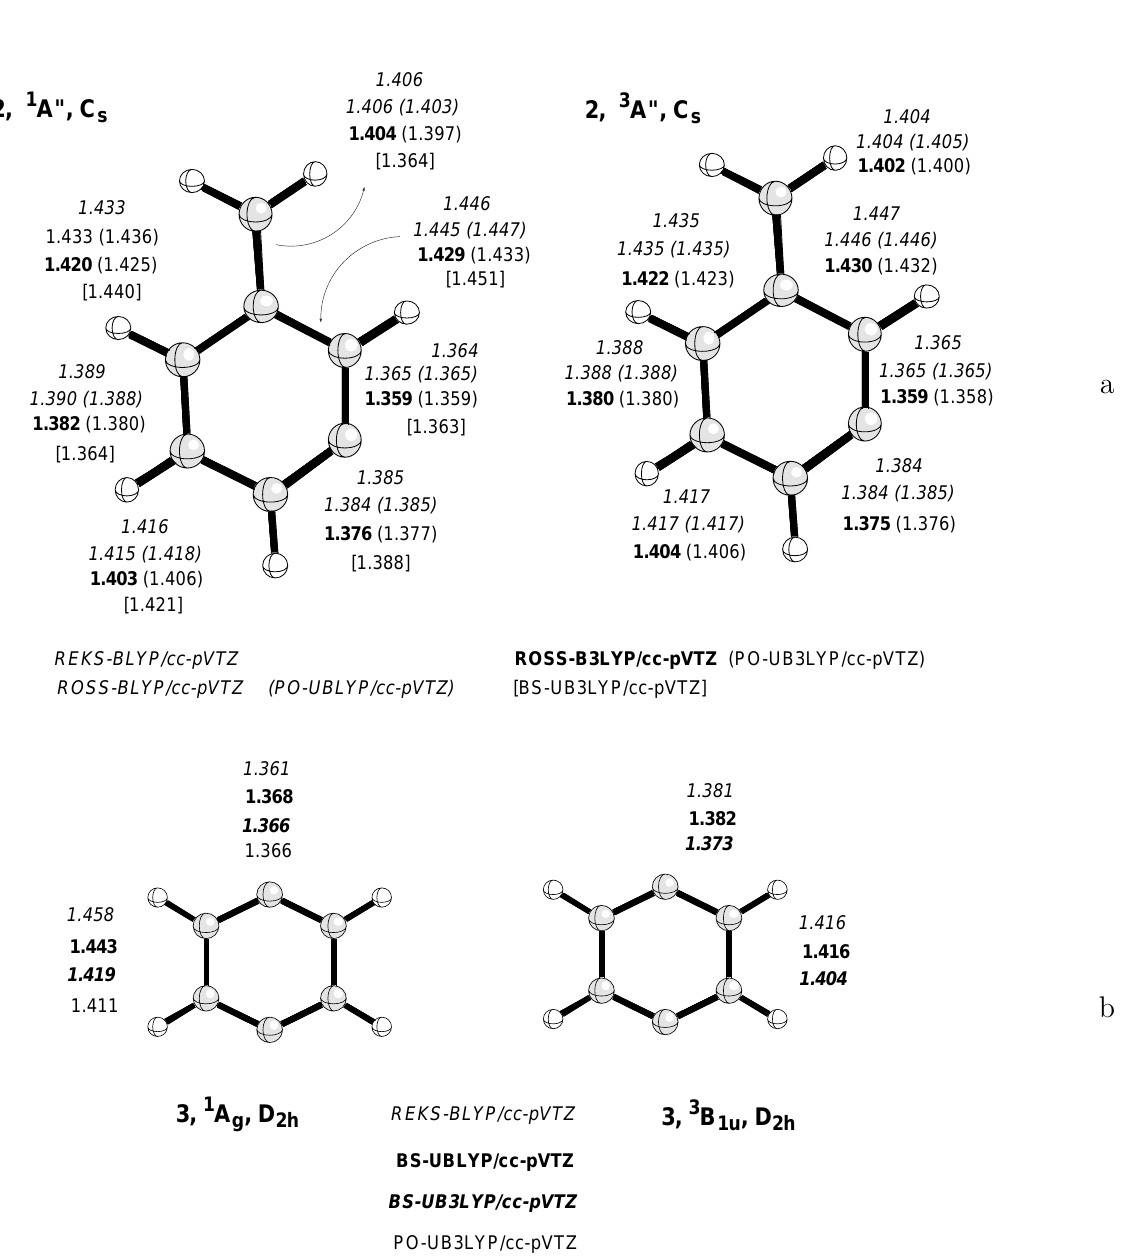
Figure 3: Calculated CC bond lengths (in ˚A) for (a) α , 3-didehydrotoluene ( 2 ) and (b) 1, 4- didehydrobenzene ( 3